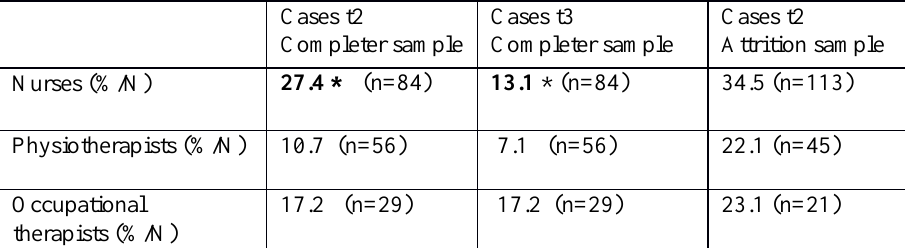
Comparisons of Proportions of students with GHQ-12 Case-Scores higher than Cut off (GHQ 12 case score >=4) for Completer Samples and Attrition